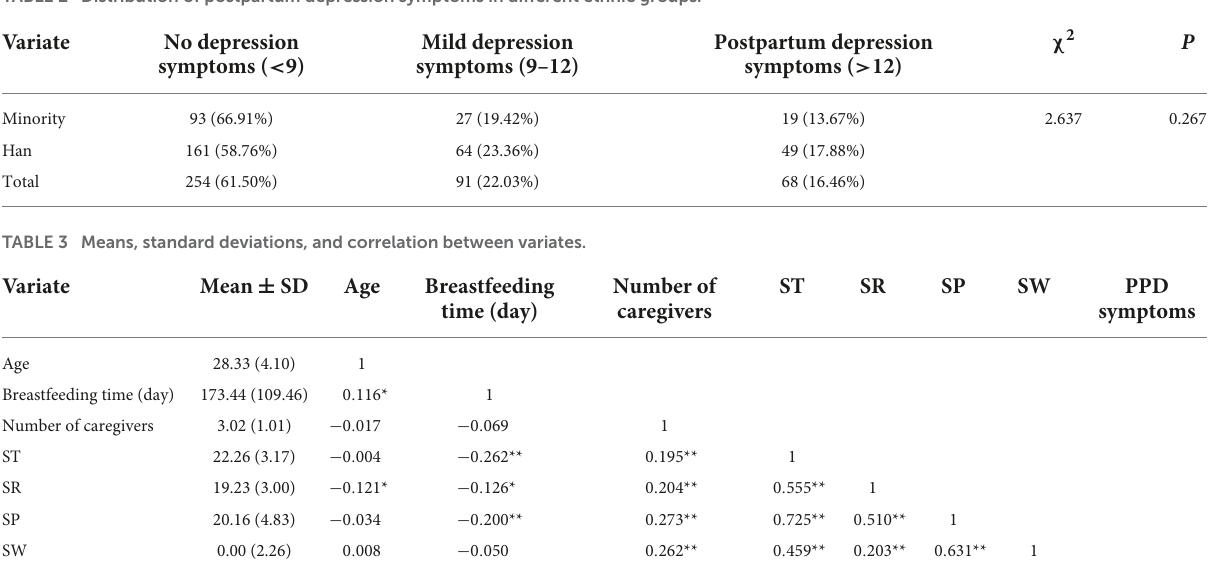
TABLE 2 Distribution of postpartum depression symptoms in different ethnic groups.